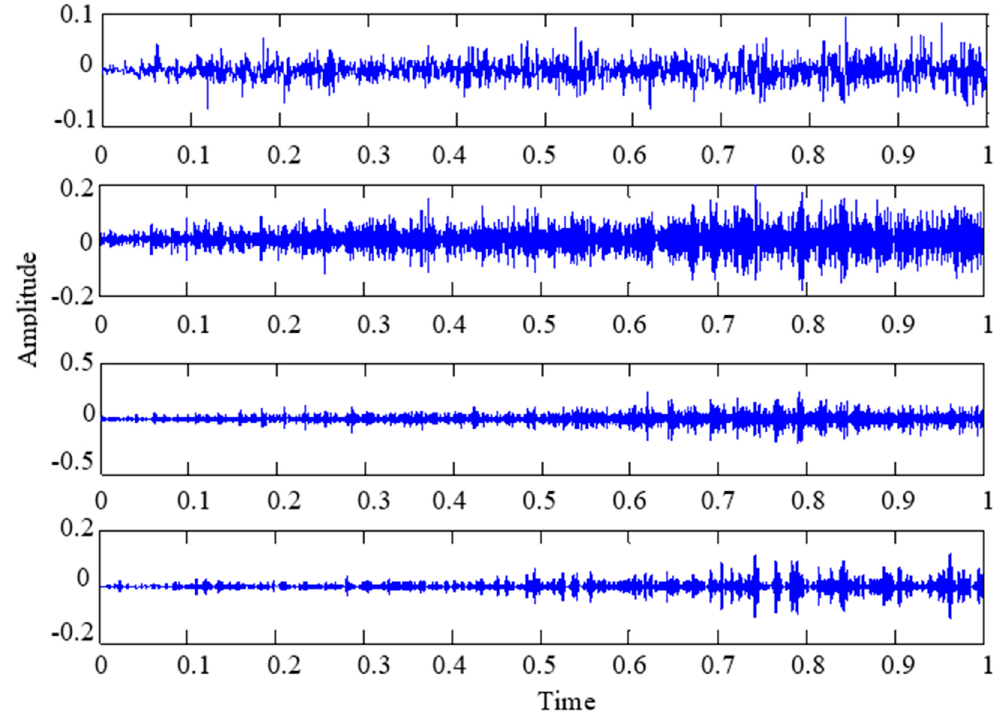
Figure 14. Angle domain waveform of extracted modes for the acoustic signal by empirical wavelet transform (EWT).